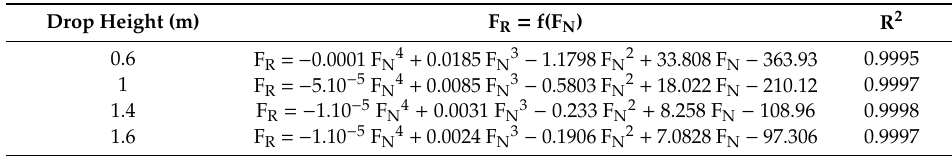
Table 12. Correlation between the impact force F R and the tensile force F N for the drop hammer weight of 100 kg without the support